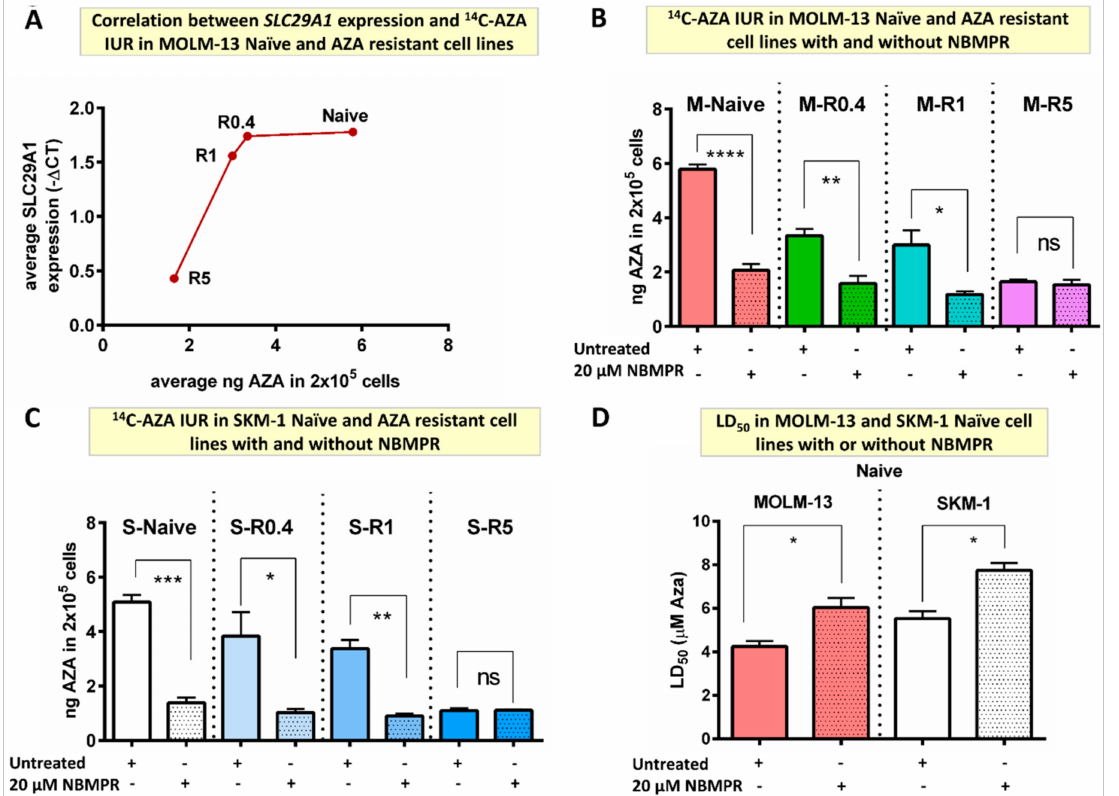
Figure 3. SLC29A inhibitor decreased 14 C-AZA IUR in MOLM-13- and SKM-1-naïve and AZA- resistant cell lines. ( A ) SLC29A1 expression was downregulated in resistant cells compared to naïve MOLM-13 cells. Importantly, 14 C-AZA IUR was inversely corelated to SLC29A1 expression; NBMPR, an SLC29A inhibitor, reduced 14 C-AZA IUR in ( B ) MOLM-13- and ( C ) SKM-1-naïve and intermediate resistant (R0.4 and R1) but not in highly resistant (R5) cells; ( D ) NBMPR reduces sensitivity to AZA in MOLM-13- and SKM-1-naïve cells. Data represent the mean and all error bars indicate SEM of at least 3 independent experiments. AZA, azacitidine; M, MOLM-13; S, SKM-1; ns, not significant. Unpaired Student’s t -test (Welch’s correction was applied for data groups with unequal SD) was used to detect statistically significant differences between cohorts. Asterisks display p -values * p < 0.05, ** p < 0.01, *** p < 0.001, **** p < 0.0001. Nitrobenzyl mercaptopurine riboside (NBMPR), an SLC29A inhibitor (Table S3), re- duced AZA IUR by almost three-fold in MOLM-13-naïve cells (5.79 ± 0.18 vs. 2.07 ± 0.23, p < 0.0001) (Figure 3B). Interestingly, NBMPR reduced 14 C-AZA IUR in cell lines